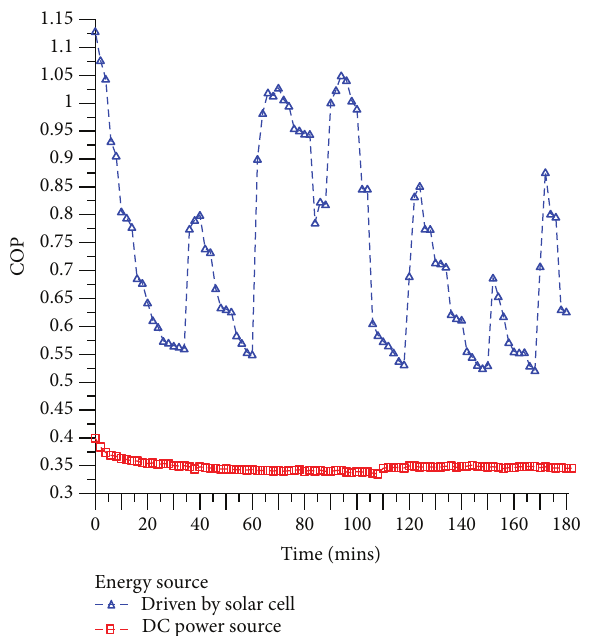
Figure11:COPsofthethermoelectricchillerbyDCsourceandsolar cells.